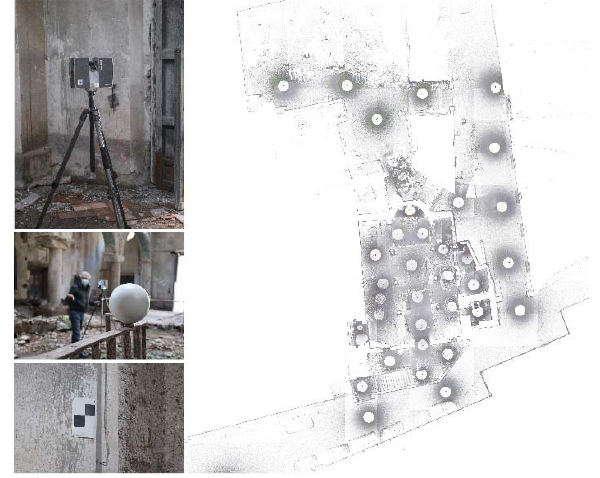
Figure 3. Laser scanning survey activities.